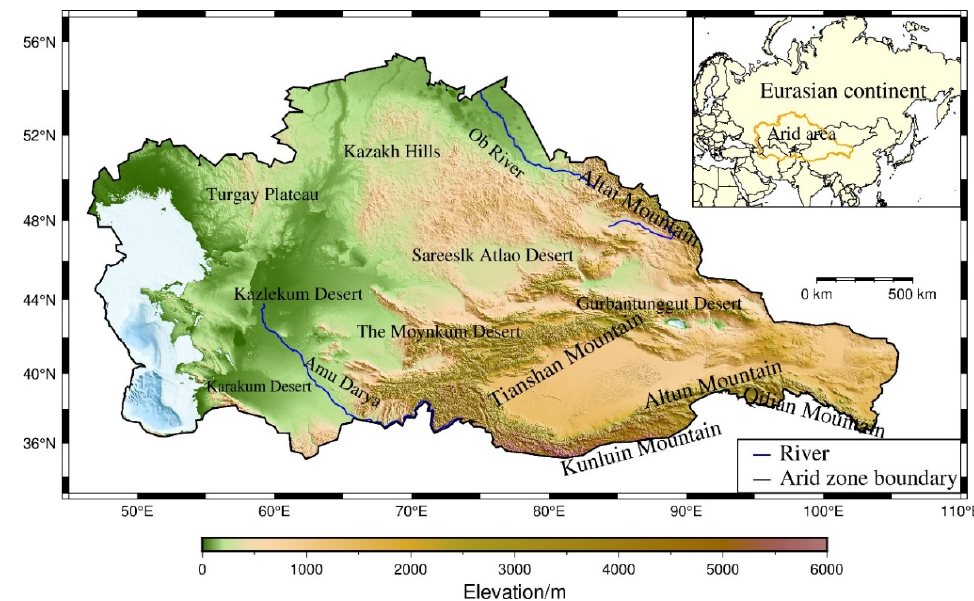
Figure 1. Overview map of the study area in the arid region of central Asia.